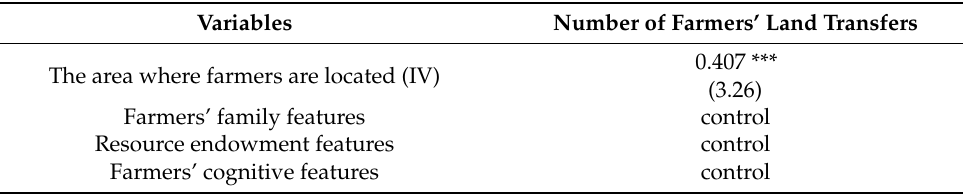
Table 4. Herd effect in farmers’ land transfer behavior: IV Results.